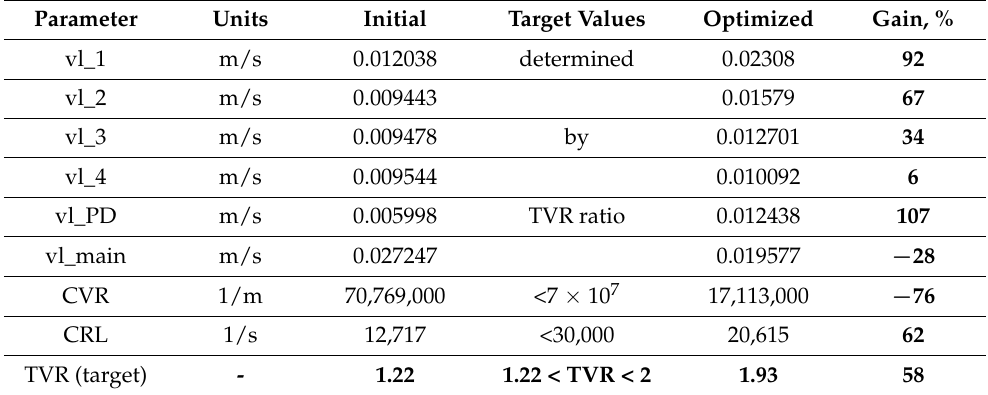
Table 1. Values of velocities, optimization objectives, and obtained gains for the initial, and optimized